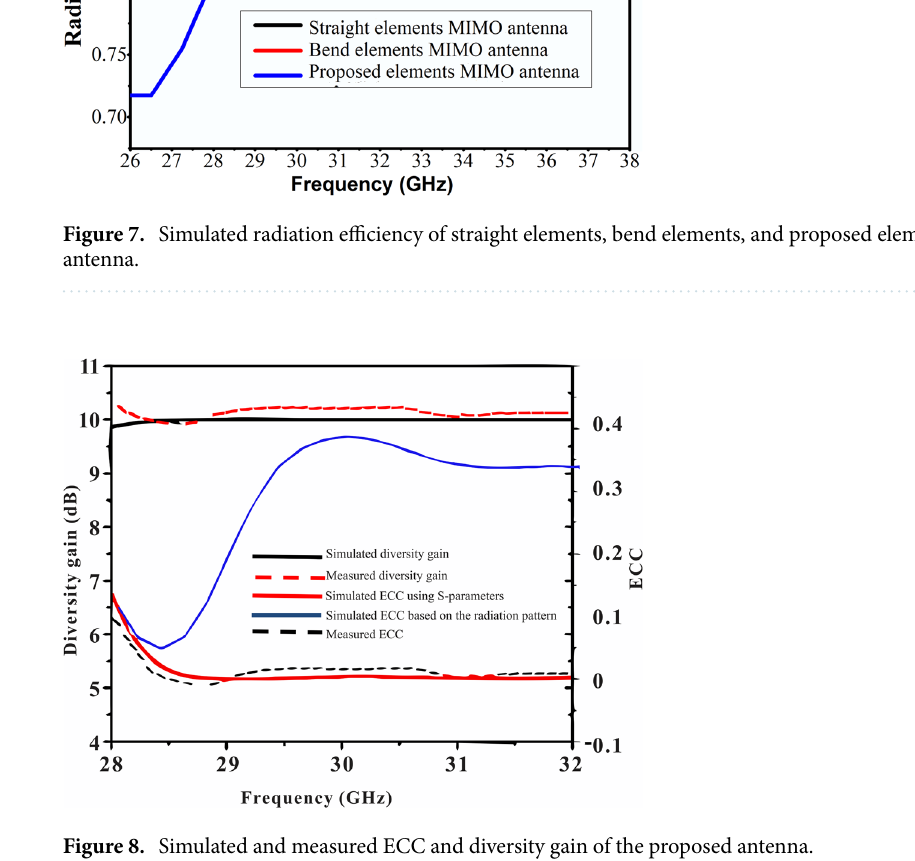
Figure 8. Simulated and measured ECC and diversity gain of the proposed antenna.